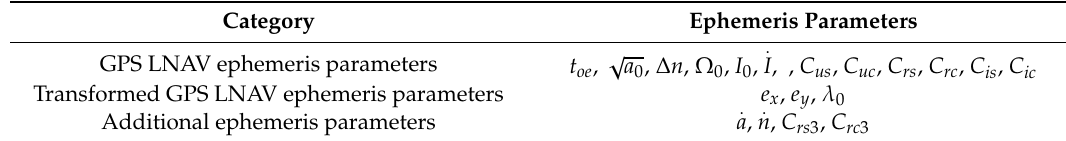
Table 4. Ephemeris parameters for low Earth orbit (LEO)